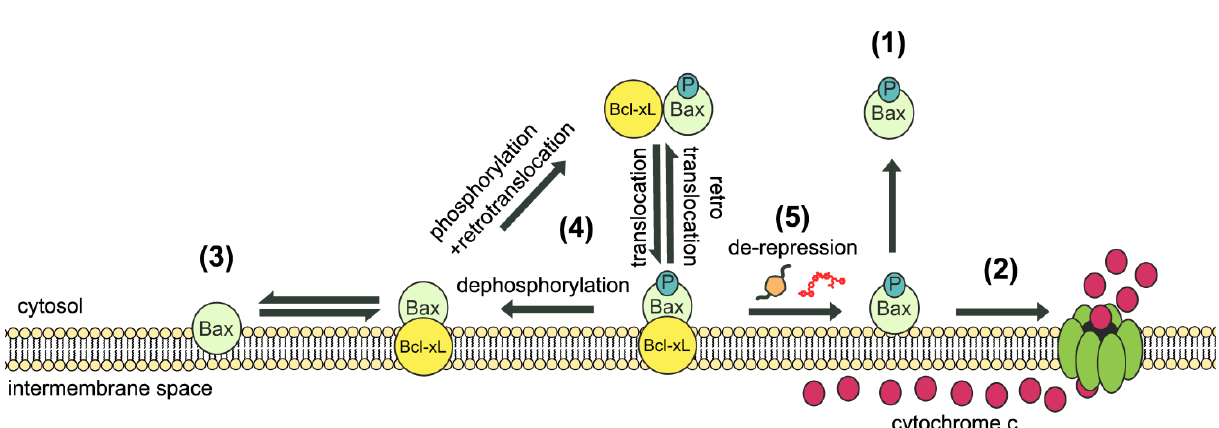
FIGURE 5: Model of dynamic equilibrium for Bax localization and activation. The model is based on data from the present paper, and from previous papers on the yeast model [20,22], and on mammalian cells [24,26,27]. (1) When Bax is phosphorylated on S184, it is spontaneous- ly mostly located in the cytosol. However, the small fraction that remains in the mitochondrial membrane is able to oligomerize to form a pore that promotes the release of cytochrome c (2) . (3) When Bax is not phosphorylated, it is spontaneously mostly located in the mito- chondrial membrane, but is unable to oligomerize to form the pore. (4) In the presence of Bcl-xL, phosphorylated Bax and Bcl-xL are con- veyed together to the membrane where the high stability of the interaction prevents the activation of Bax. Although the process is reversible through retrotranslocation, the system is favored towards Bax mitochondrial localization through the possible dephosphorylation of Bax. (5) Conversely, in the presence of derepressors of the interaction between Bax and Bcl-xL (BH3-only proteins, such as Bim, or BH3-mimetic mol- ecules, such as ABT-737), Bax is able to form a pore with great efficiency because it is already present in great amount in the membrane (see the discussion in